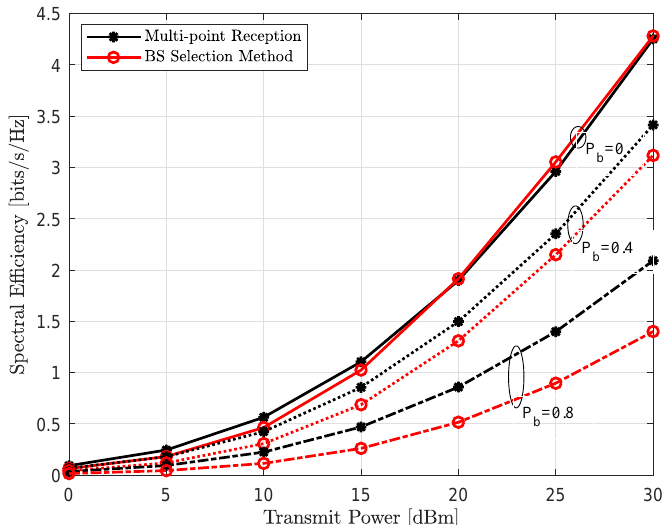
Figure 7. Achievable spectral efficiency assuming exact user location as a function of increasing uplink transmit power P t for the link blocking probability P b of P b = 0 (solid line), P b = 0.4 (dotted line) and P b = 0.8 (dash-dotted line).